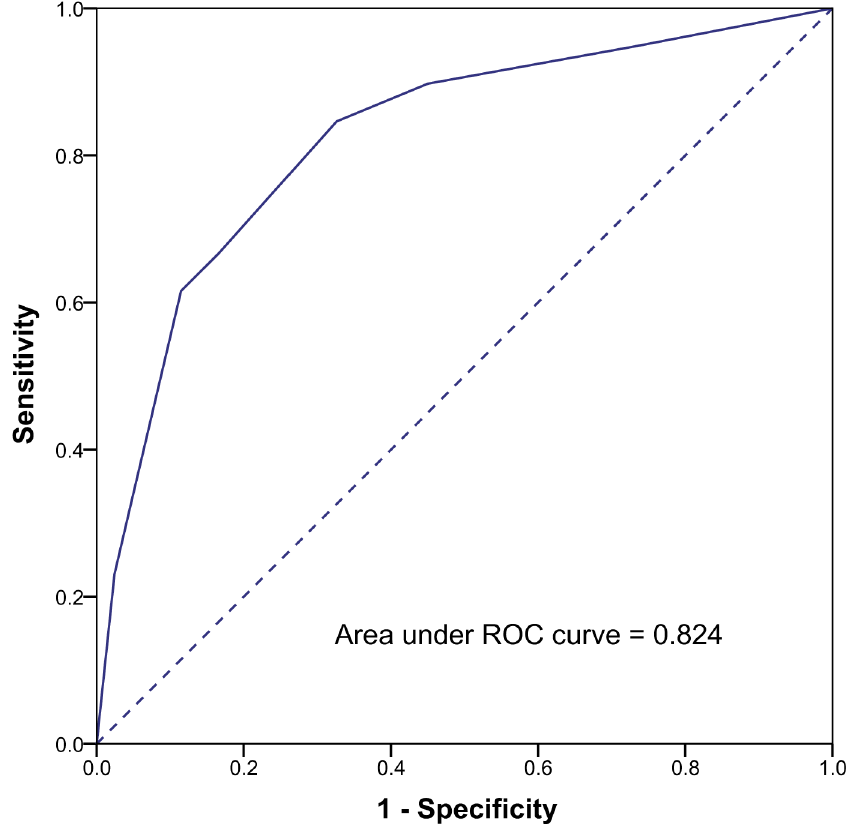
Fig 2. Performance of the prediction model for LNM in endometrial endometrioid cancer.